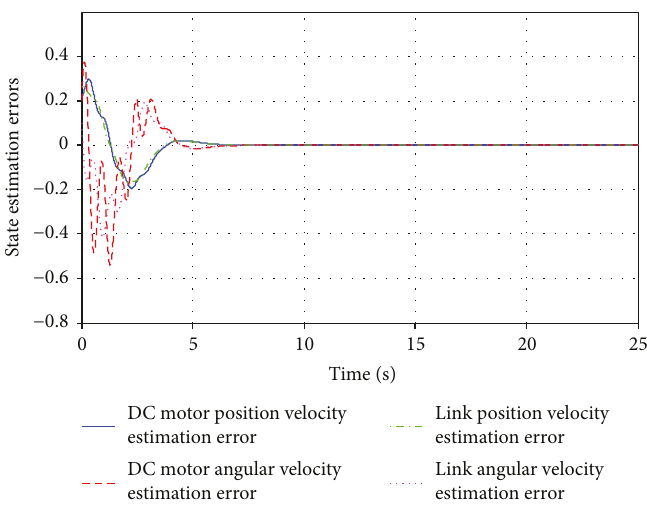
Figure 4: Nonlinear system state estimation errors.